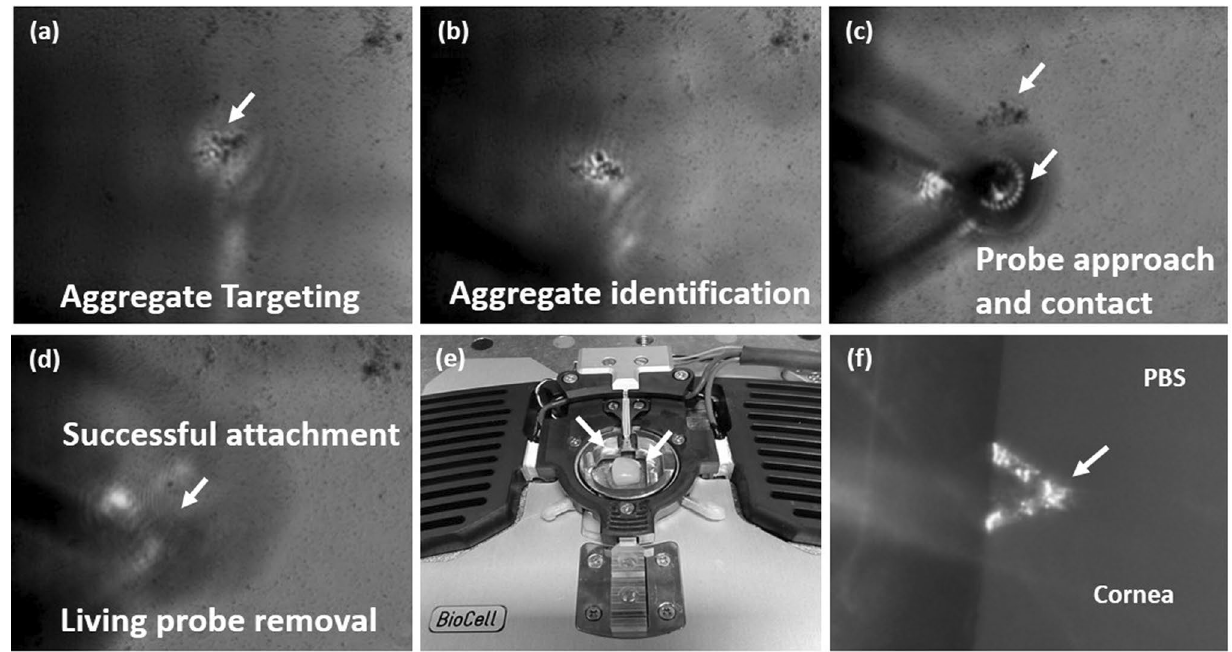
Figure 2. Showing ( a ) AFM Topview light microscope image of S. aureus -Van-HB-PNIPAM target adsorbed to glass slide under PBS conditions, ( b ) 50 µm modified spherical AFM probe functionalised with